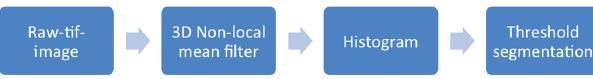
Figure 2. Simplified segmentation workflow as applied in this study.